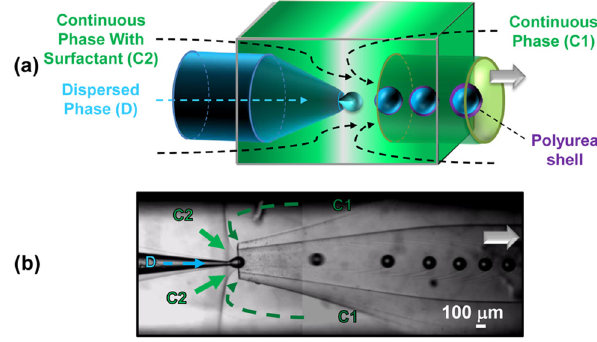
Figure 5: ( a ) Schematic fi gure of emulsion drop generation by focusing fl ow and ( b ) real micro - /nano - graph of the glass capillary during the micro - /nano - droplet formation [ 58